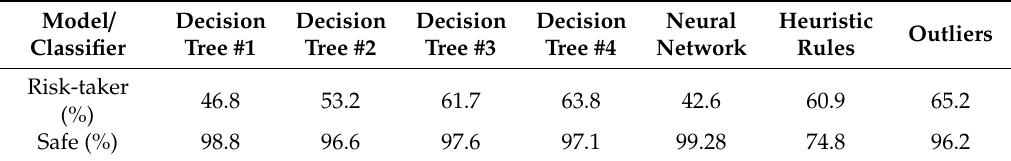
Table 5. Classification